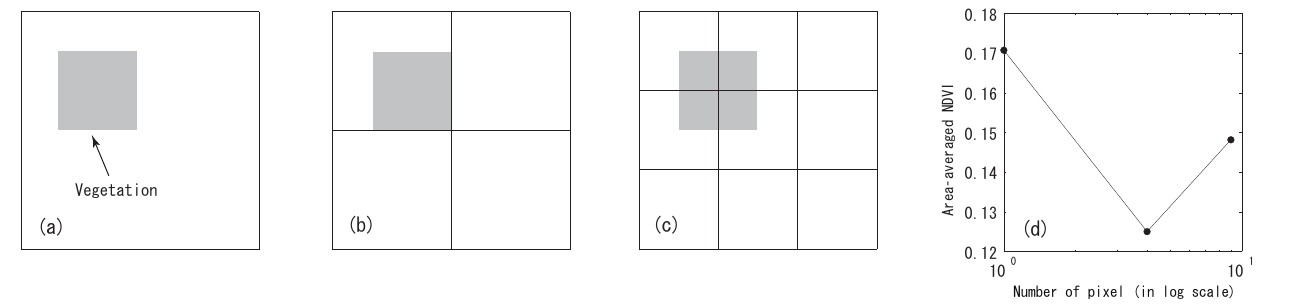
Figure 1. Non-monotonic behavior on an area-averaged NDVI as a function of the number of pixels (spatial resolution) over a fixed area. ( a ), ( b ), or ( c ) illustrate the hypothetical image obtained for one, four, or nine pixels within a fixed area that includes vegetation and soil backgrounds. The vegetation spectrum (covering both red and NIR reflectance spectra) is assumed to be (0 : 05 ; 0 : 4) , and the soil background spectrum is (0 : 15 ; 0 : 15) . ( d ) The area-averaged NDVI as a function of the number of